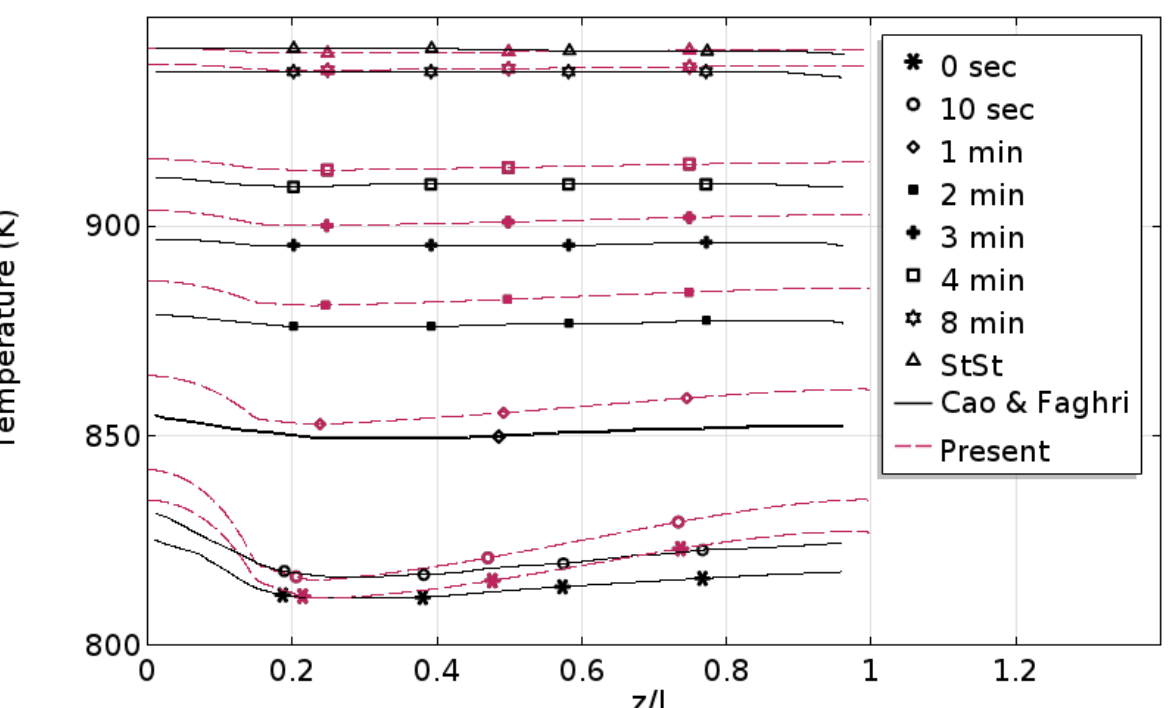
Figure 5. The vapor temperature along the centerline for different periods (solid lines represent the Cao and Faghri results).